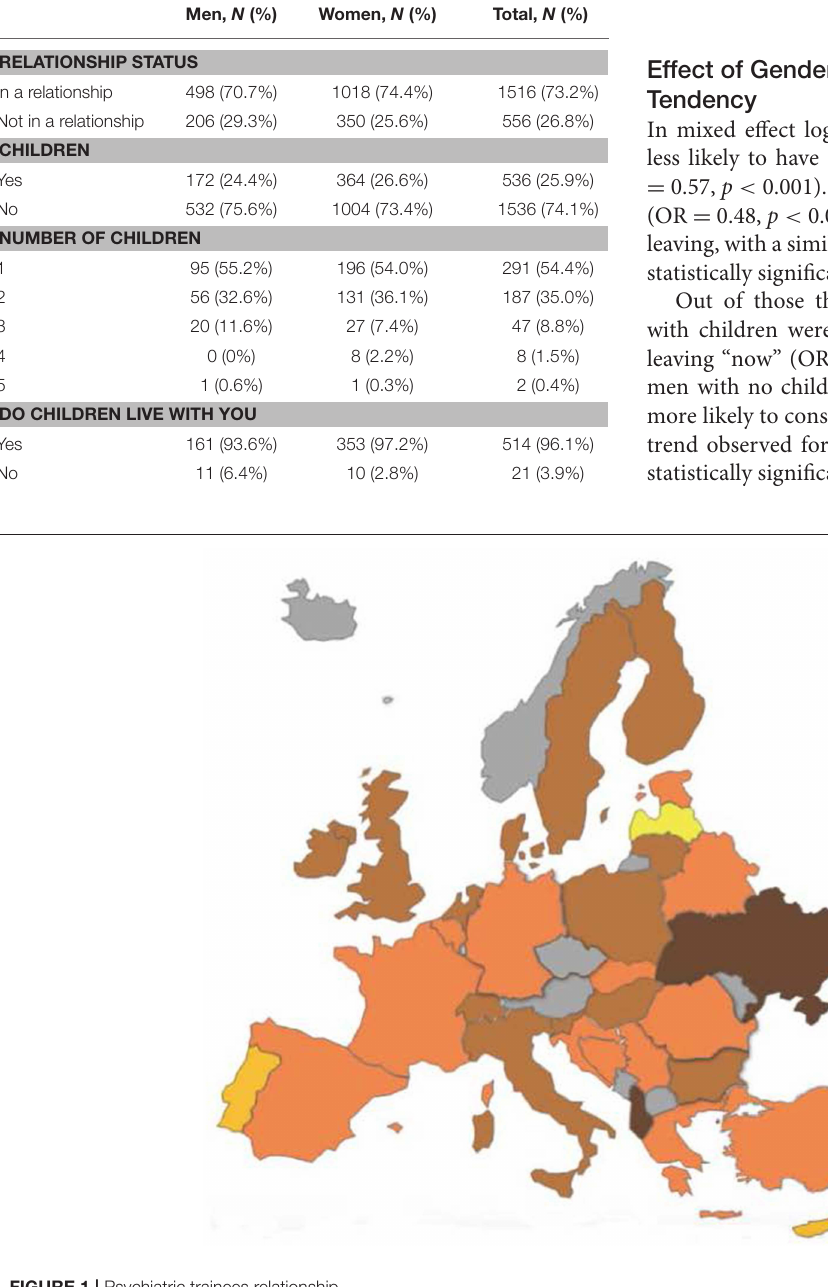
TABLE 2 | Family arrangements (relationship and children).